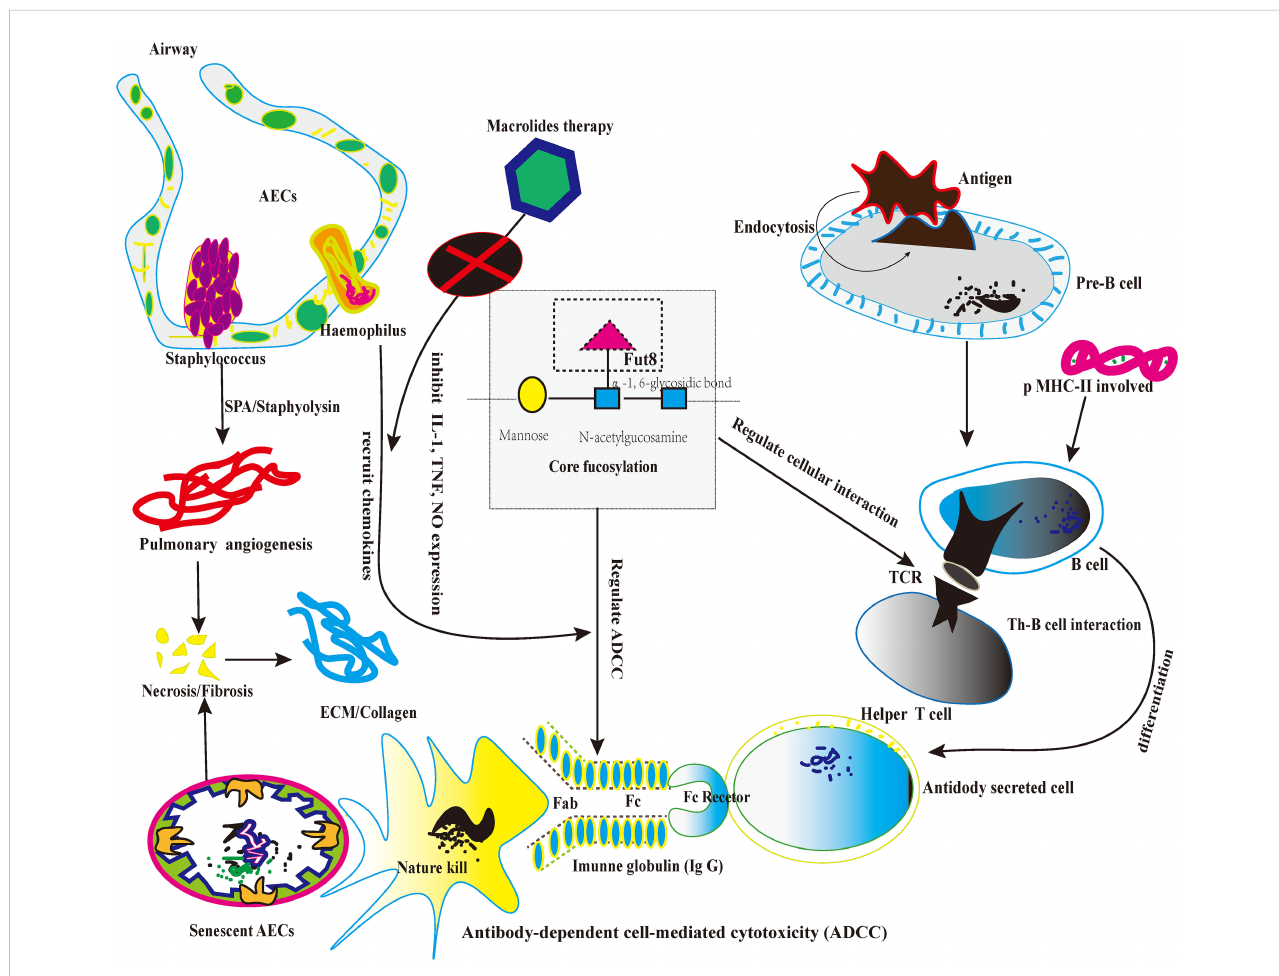
FIGURE 3 The picture depicts the core fucosylation regulates ADCC and lymphocyte information transduction about lung fi